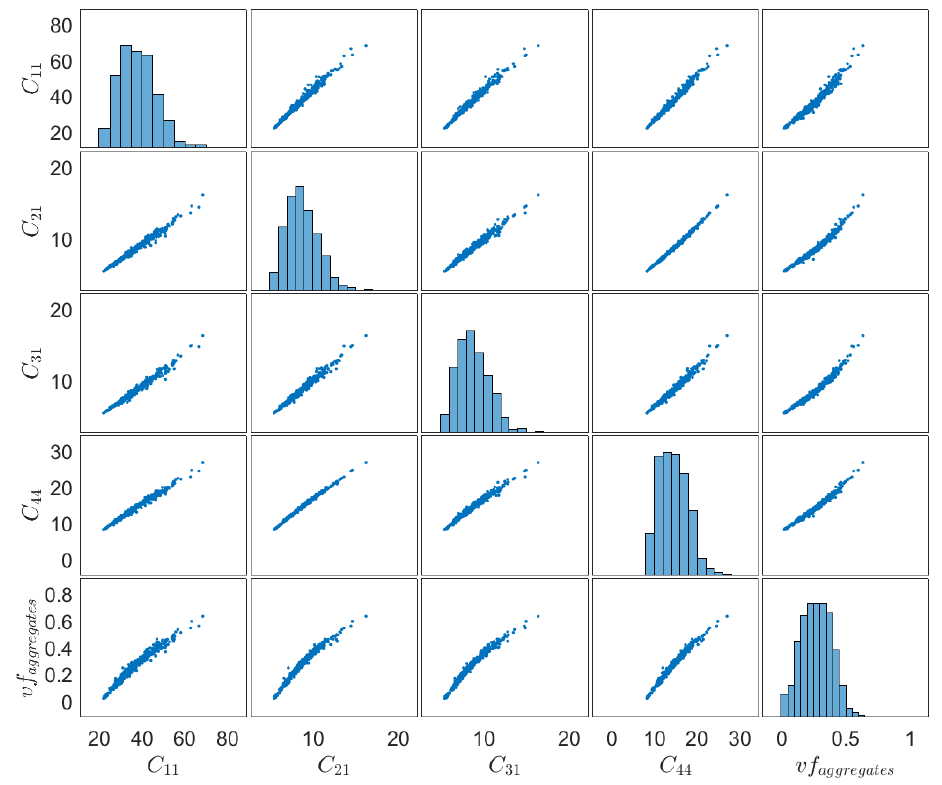
Figure 11. Scatter plots of elasticity components ¯ C 11 , ¯ C 21 , ¯ C 31 , ¯ C 44 and vf of aggregates for δ 3 (correspondence of subscripts: 1 → 11, 2 → 22, 3 → 33, 4 →